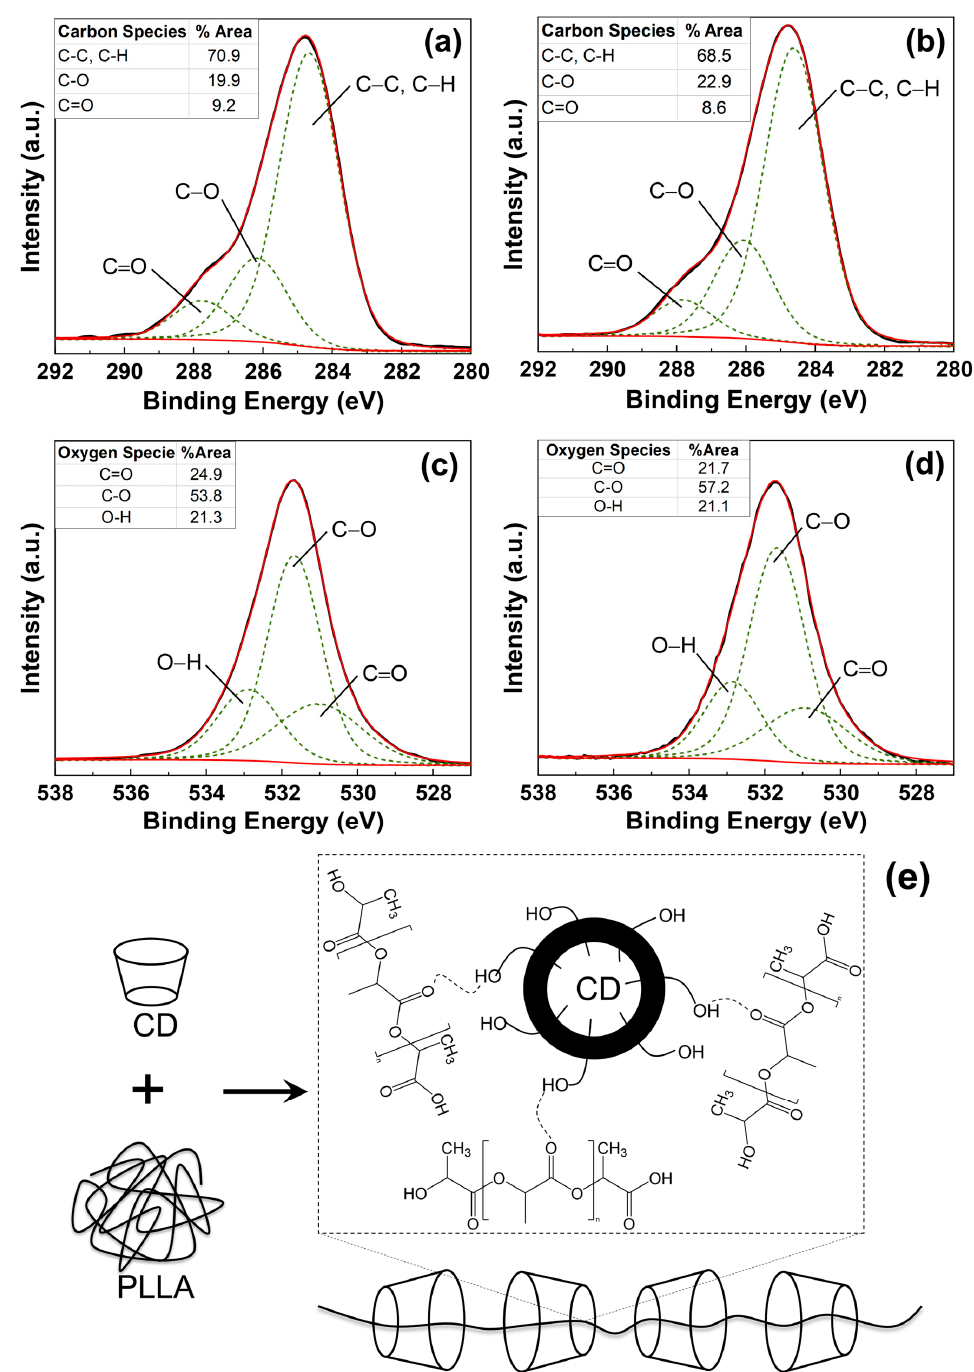
Figure 4. C1s XPS spectra of ( a ) PLLA and ( b ) 2.5 wt% CD/PLLA and O 1s XPS spectra of ( c ) PLLA, ( d ) 2.5 wt% CD/PLLA electrospun nanofibers. ( e ) the schematic illustration of the interaction between CD and PLLA.